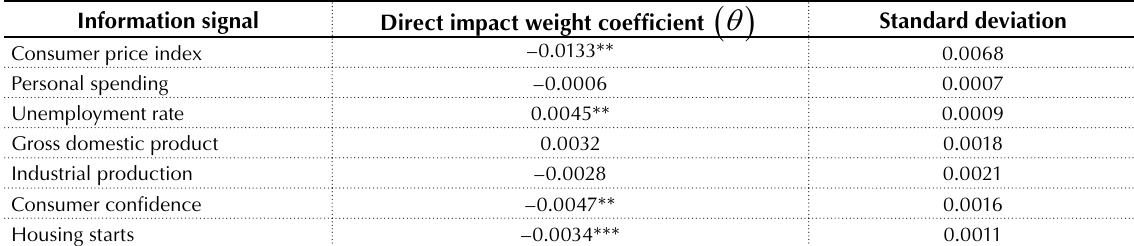
Table 3. The influence of the component of “surprise” on non-monetary information signals of the USA on the volatility of stock prices of enterprises of Ukraine in the economic sector “Basic Materials”